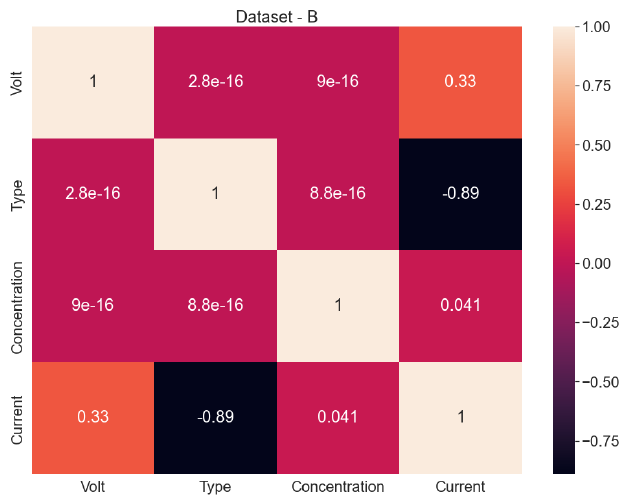
Figure 6. Correlation matrix of Dataset B.